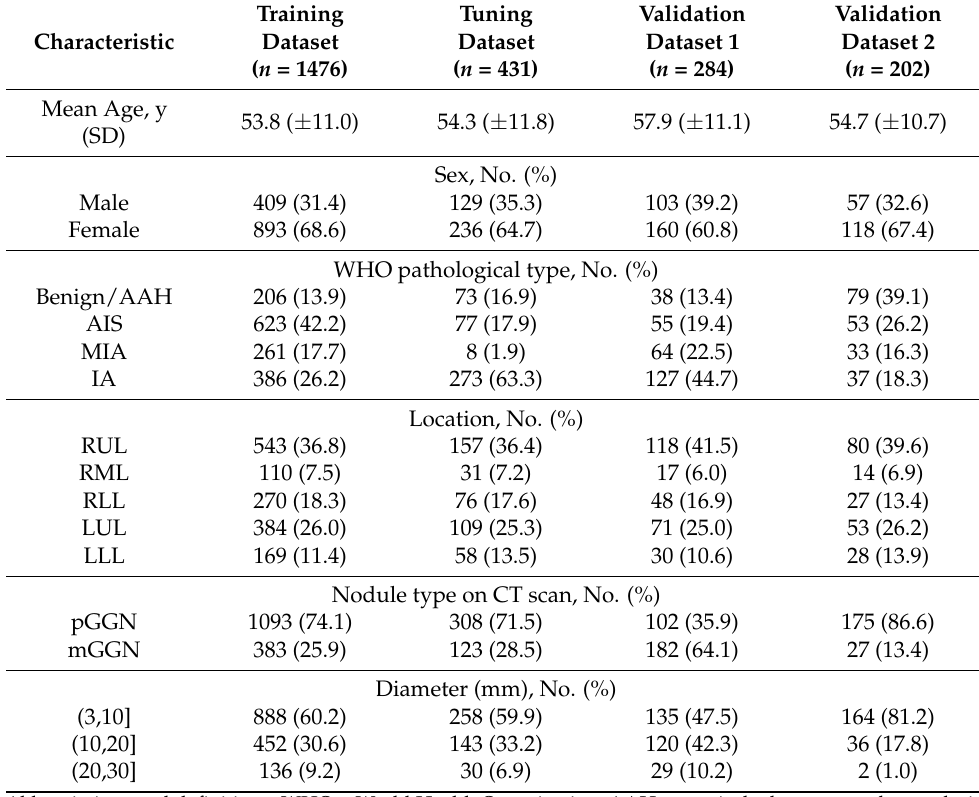
Table 1. Clinical characteristics of the patients in the training, tuning, and validation